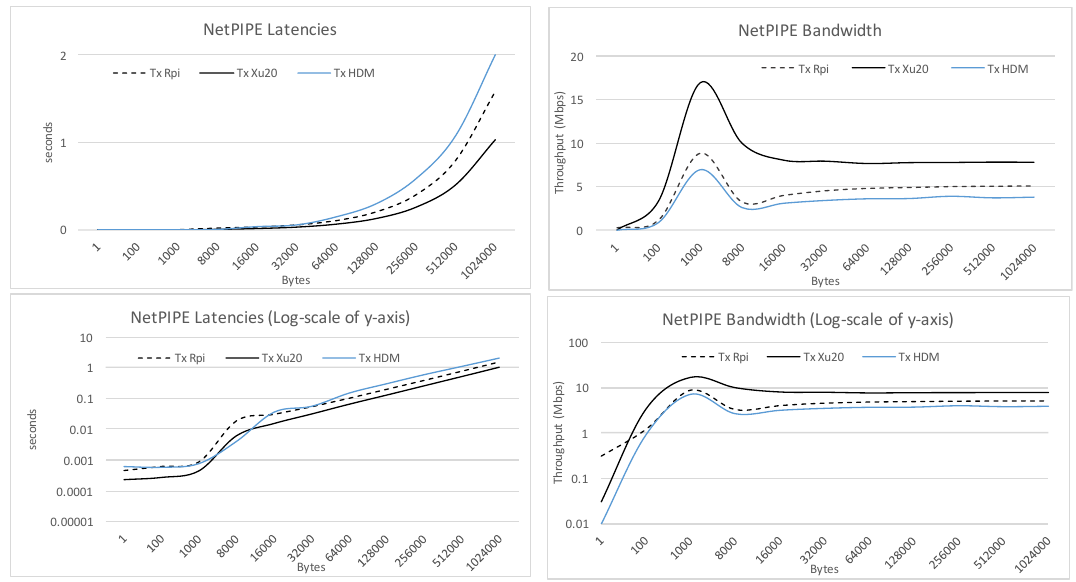
Figure 2. NetPIPE benchmark results for all clusters considering latencies and bandwidth with data size in terms of bytes on the